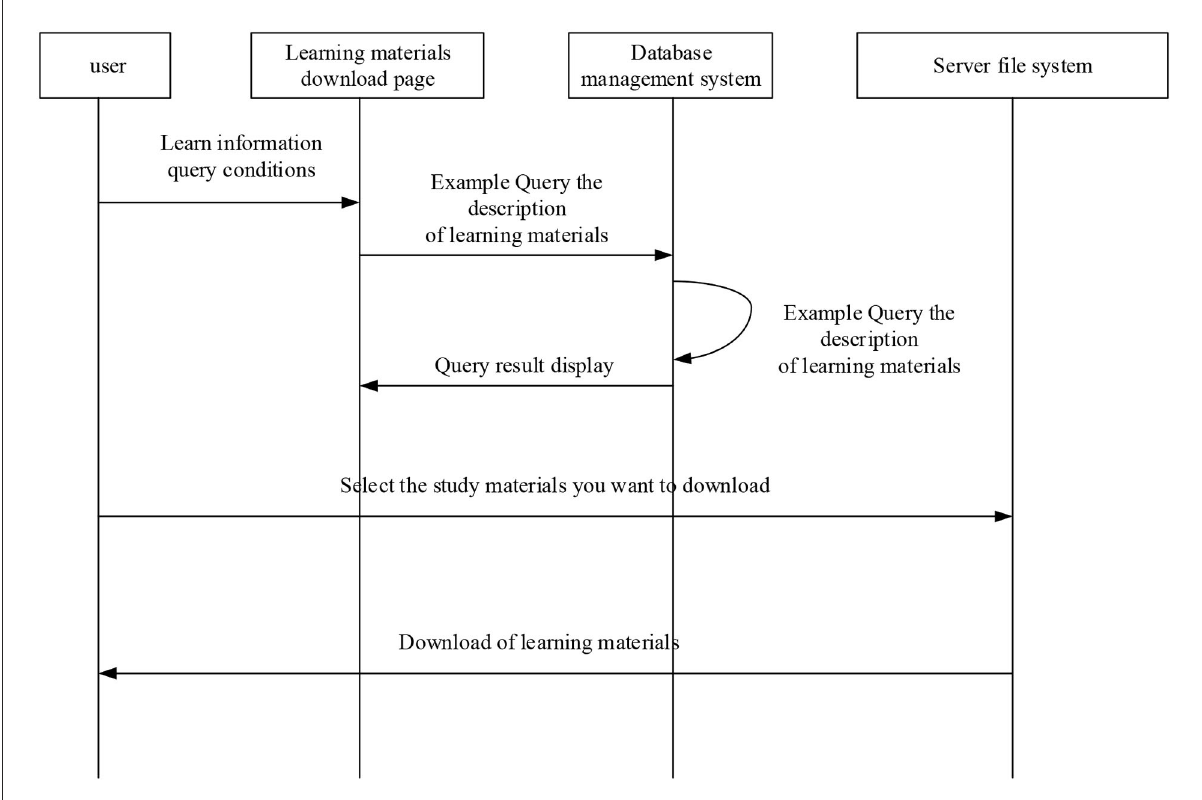
FIGURE14 Sequence diagram of the micro-video